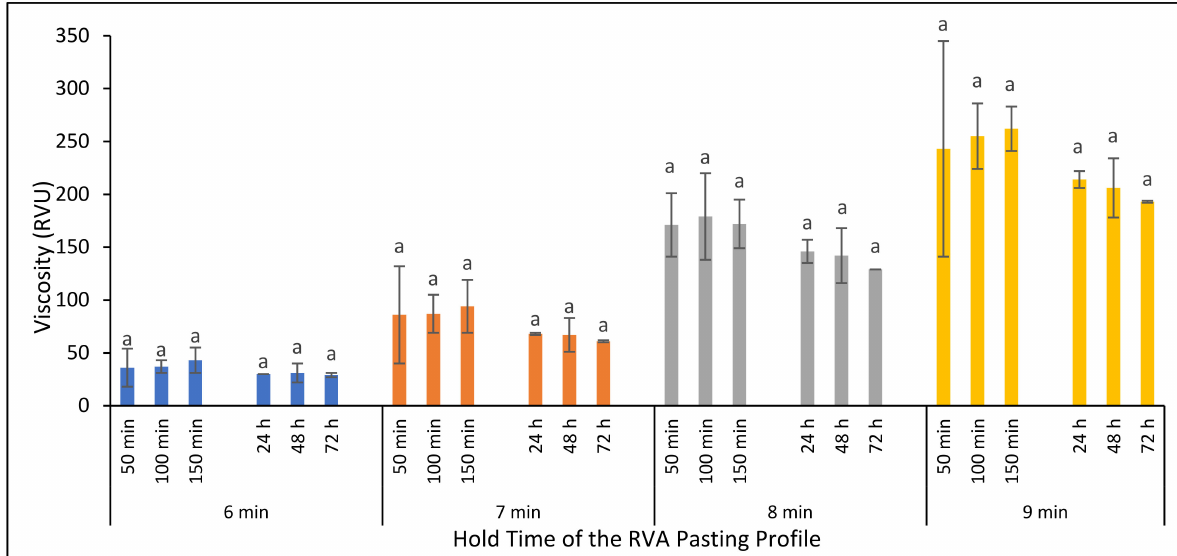
Figure 3. Ferment viscosity at 6–9 min holding time of the pasting profile during fermentation and over a 72 h storage. Bars represent the means and standard deviations of two replications. No significant differences were detected for the results at p < 0.05 (Tukey–Kramer test) for each holding time as indicated with the bars with the same